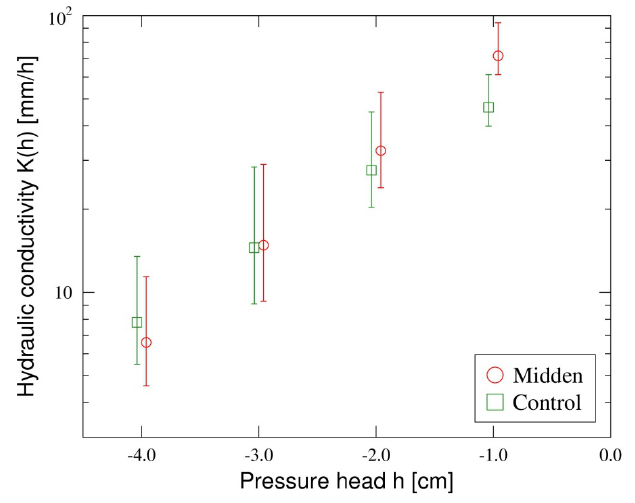
Fig. 7. Mean estimates of near-saturated hydraulic conductivity (K( h )) measured at earthworm midden and non-midden sites. Error bars denote 95% confidence interval, differences only significant for pressure head (h) = –1 cm. For clarity, overlapping data points are displaced